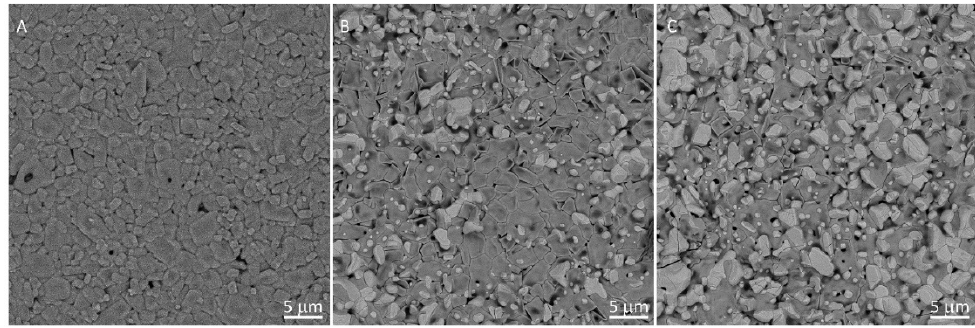
Figure 4. SEM photos of polished and thermally etched ( A ) α - β 0T, ( B ) α - β 10T, and ( C ) α - β 20T composites.